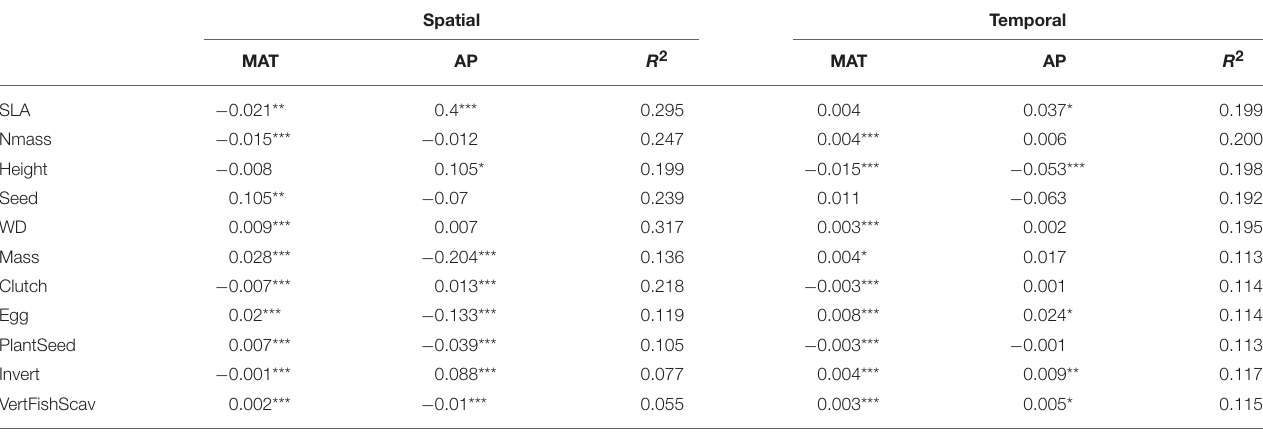
TABLE 1 | Summaries of models (mean coefficients and mean R 2 values) relating spatial or temporal patterns of functional composition with mean annual temperature (MAT) and annual precipitation (AP).